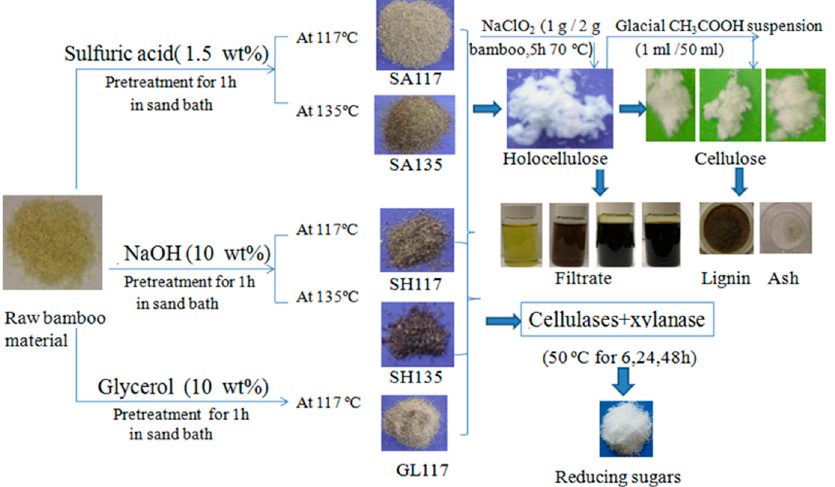
Figure 1. Scheme for preparing the bamboo samples and isolating cellulose, hemicelluloses, and lignin.